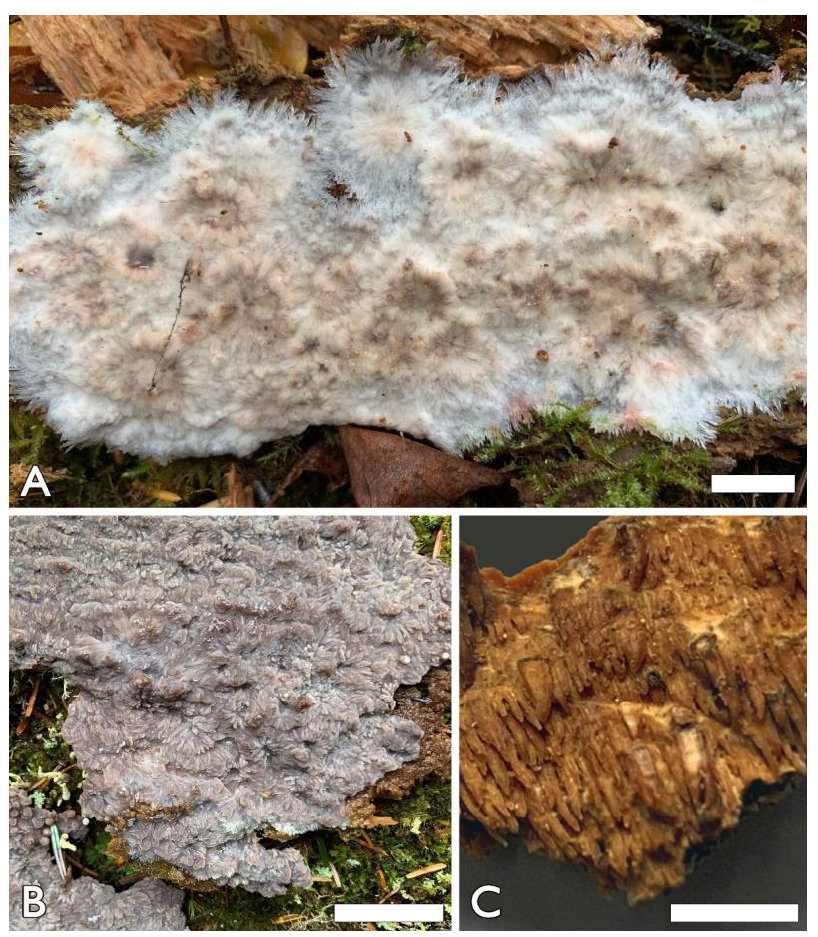
Figure 2. Basidiomata of Hermanssonia fimbriata and Phlebia austroasiana. ( A ) Juvenile basidiomata of Hermanssonia fimbriata (Holotype, Dai 23266). ( B ) Mature basidiomata of H. fimbriata (Paratype, Dai 23305). ( C ) Basidiomata of Phlebia austroasiana (Holotype, Dai 17556). Scale bars = 1.0 cm ( A , B ); 0.5 cm ( C ). Photo by: Yu-Cheng Dai ( A , B ) and Zhan-Bo Liu ( C ).